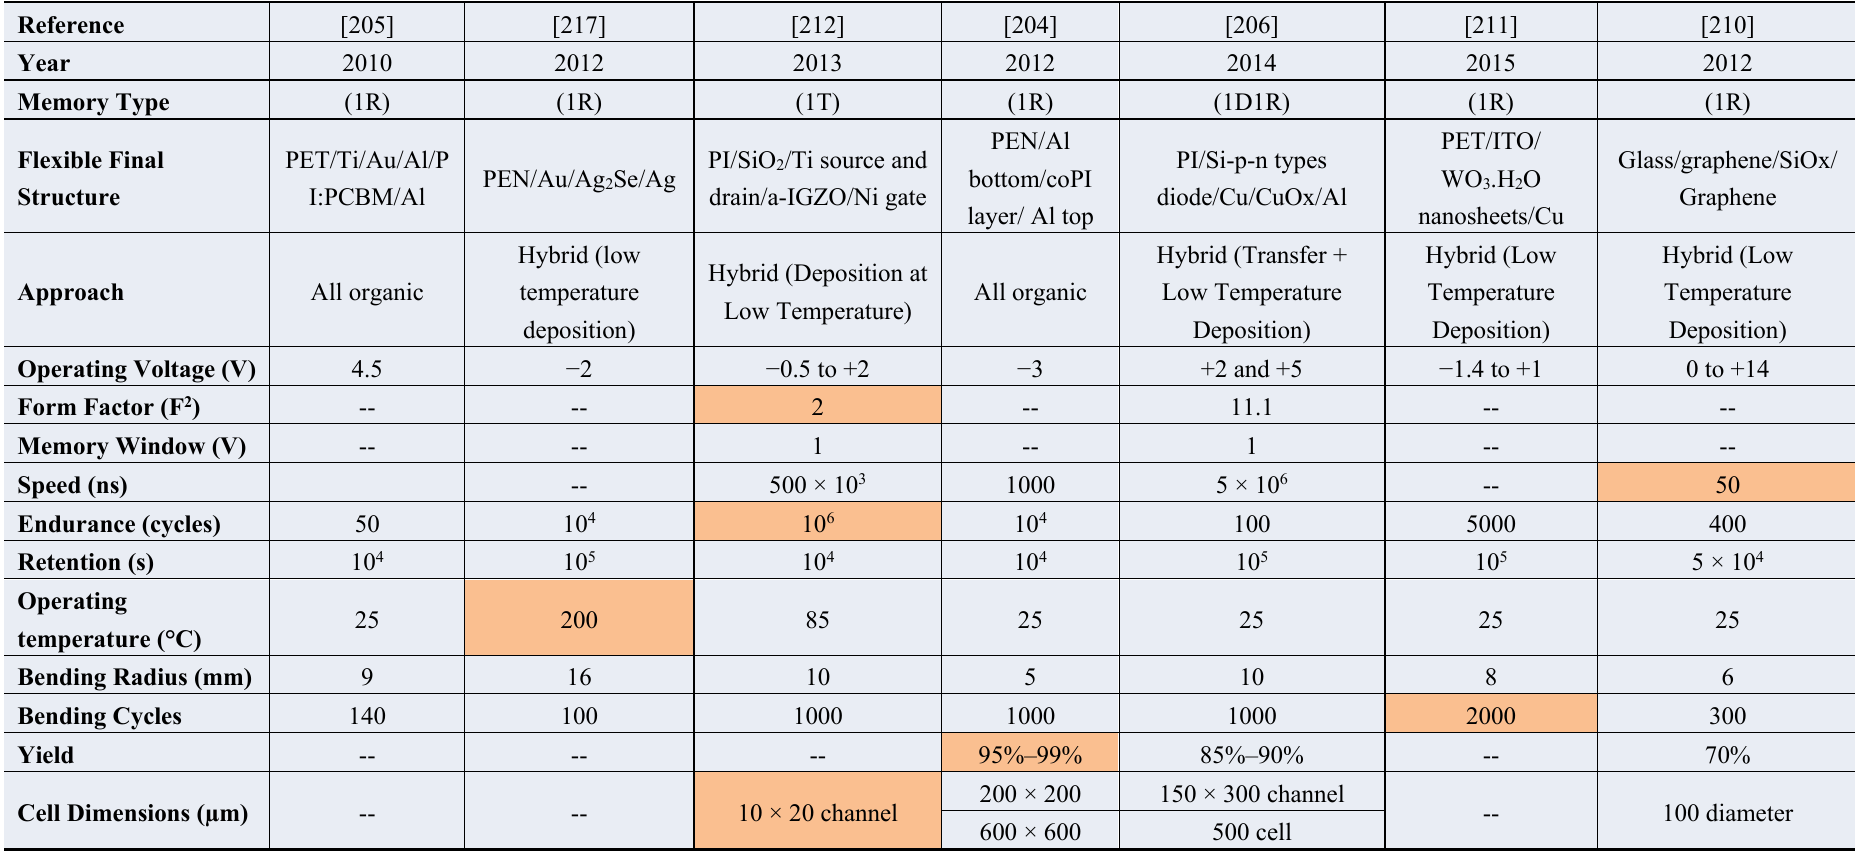
Table 5. Summary of the key works on flexible resistive random access memory (ReRAM) over the past five